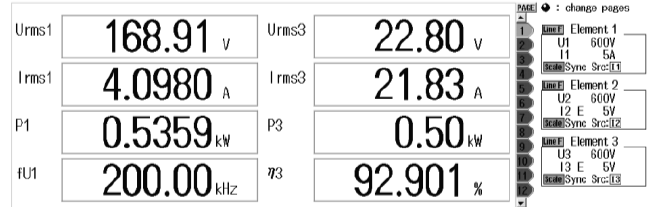
Figure 18. Output characteristics without UAV.